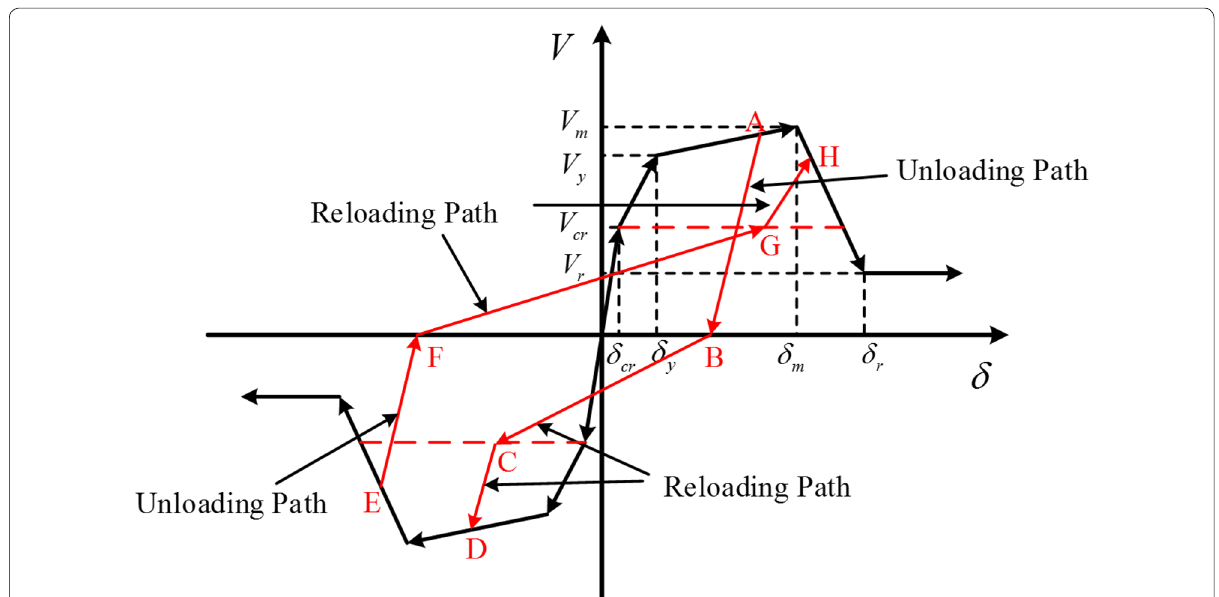
Fig. 5 Hysteretic shear model for diagonally reinforced coupling